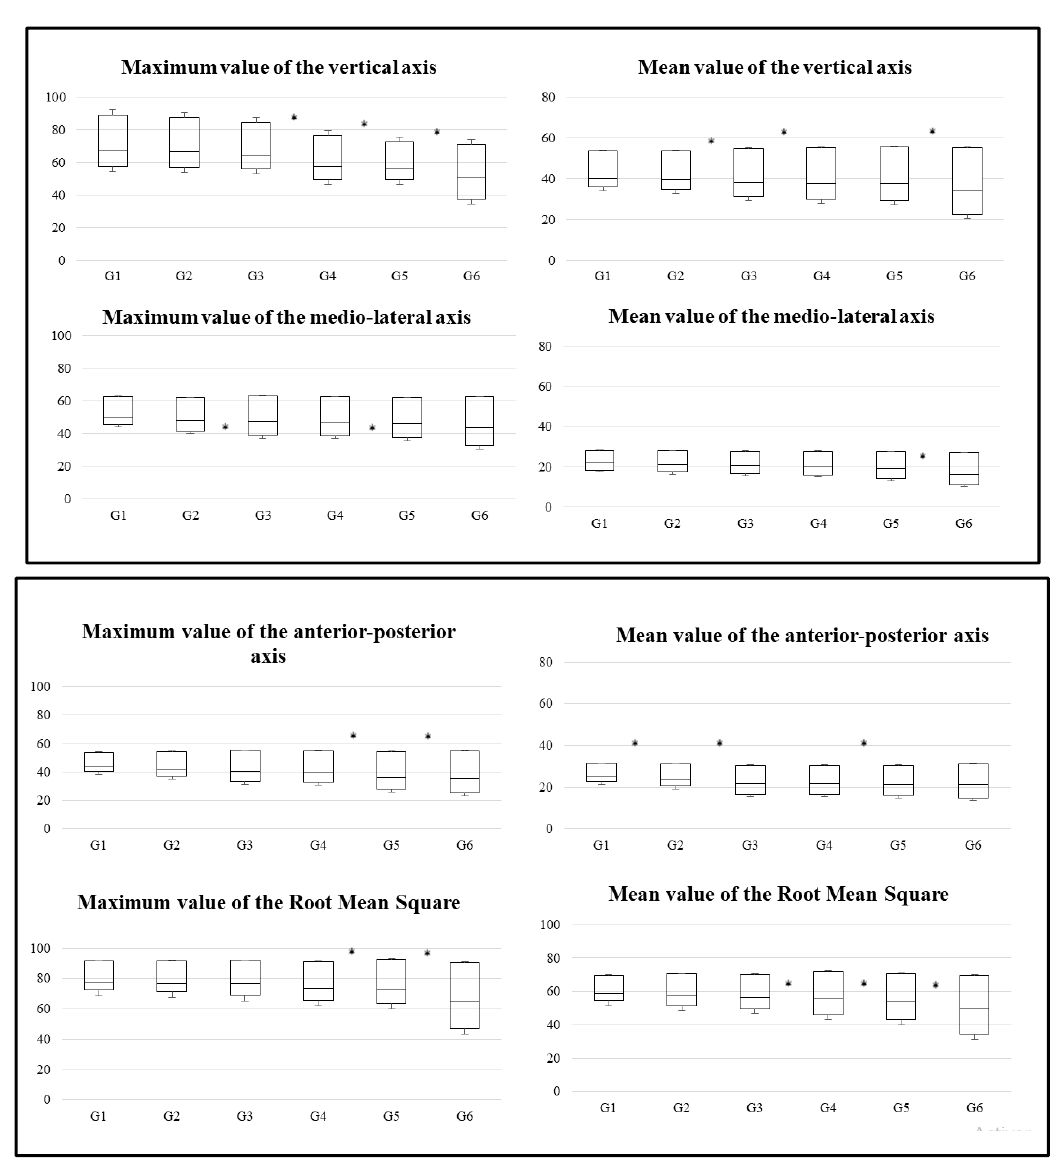
Figure 2. Box charts for the three axes and root mean square by age group. * Indicates statistically significant differences ( p < 0.05) between the groups.